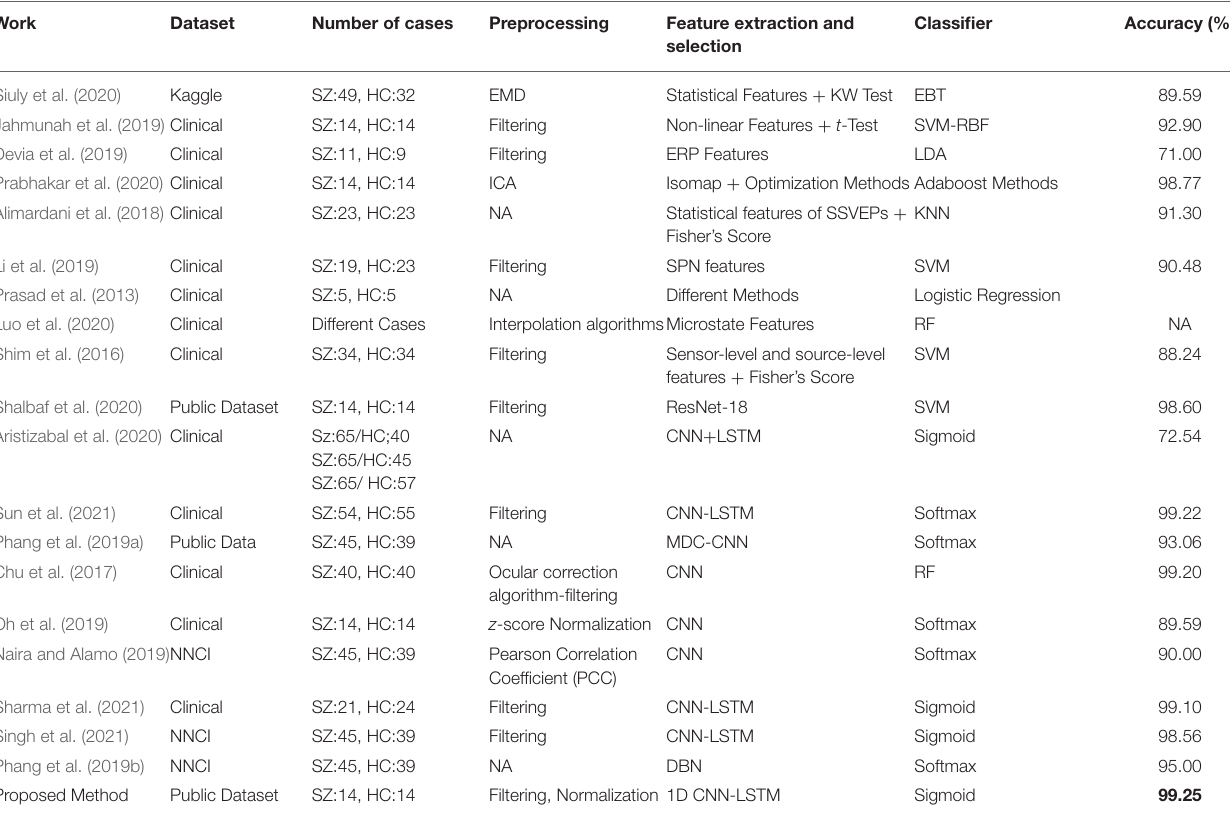
TABLE 13 | The proposed method compared with related works in diagnosis of